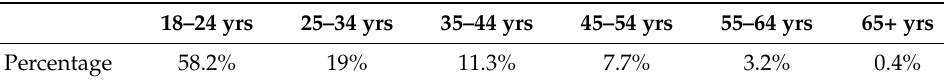
Table 3. Age profile of e-survey respondents.